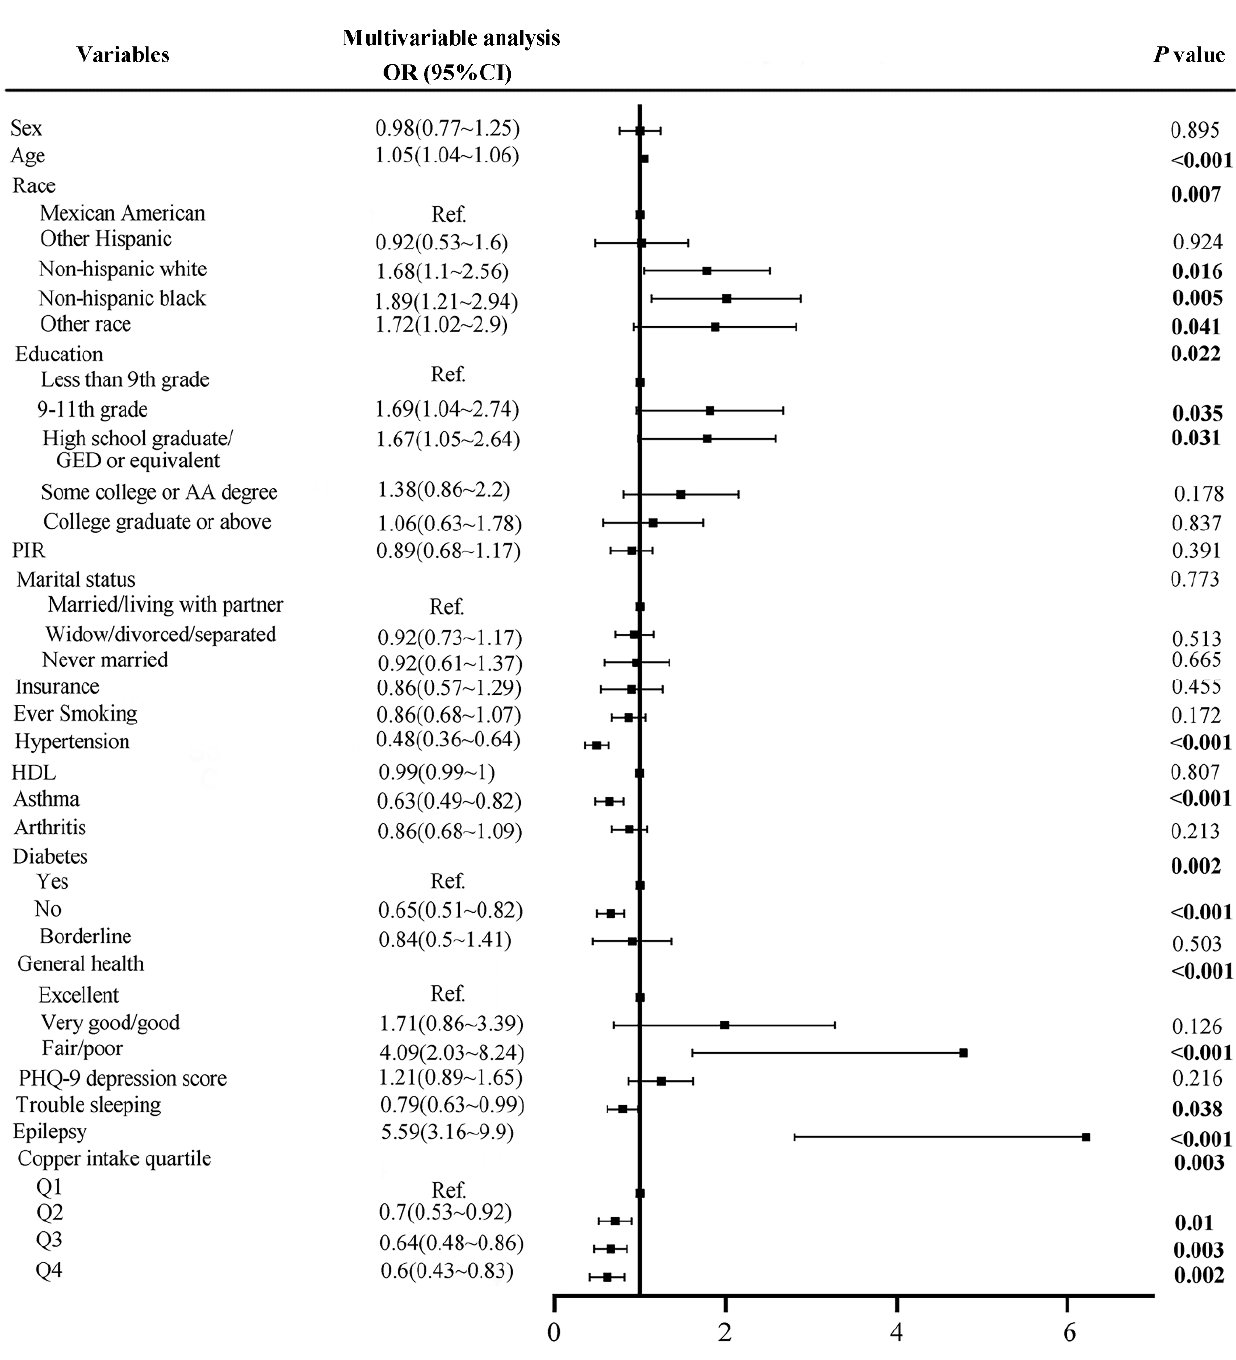
Figure 2. Forest plot of stroke risk factors before matching. Subsequently, a stratified analysis was used to assess whether the association between copper intake and stroke risk differed by sex, age (<65 and ≥ 65 years), smoking status, hypertension, and diabetes. When the analysis was stratified by sex, the association between copper intake and stroke risk was more significant in female individuals ( p = 0.002; Table S1). Similarly, the association between copper intake and stroke was more meaningful in individuals aged <65 years old ( p = 0.013; Table S2), individuals with hypertension ( p = 0.002; Table S3), individuals who smoke ( p = 0.027; Table S4), and individuals with diabetes ( p = 0.013; Table